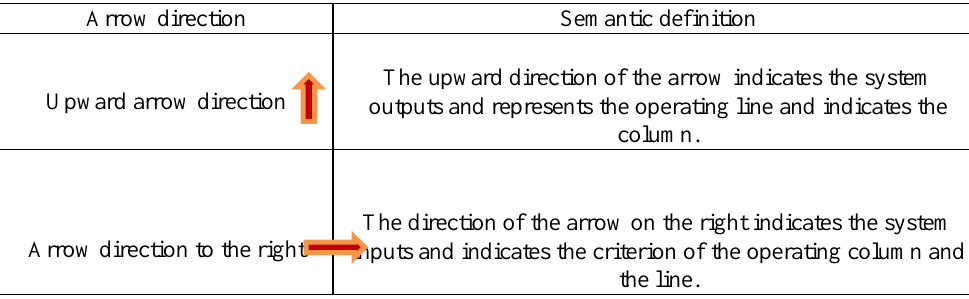
Table 5. Definition of arrow direction in the analysis of internal relationships of links Arrow direction Semantic definition The upward direction of the arrow indicates the system Upward arrow direction outputs and represents the operating line and indicates the column. The direction of the arrow on the right indicates the system Arrow direction to the right inputs and indicates the criterion of the operating column and the